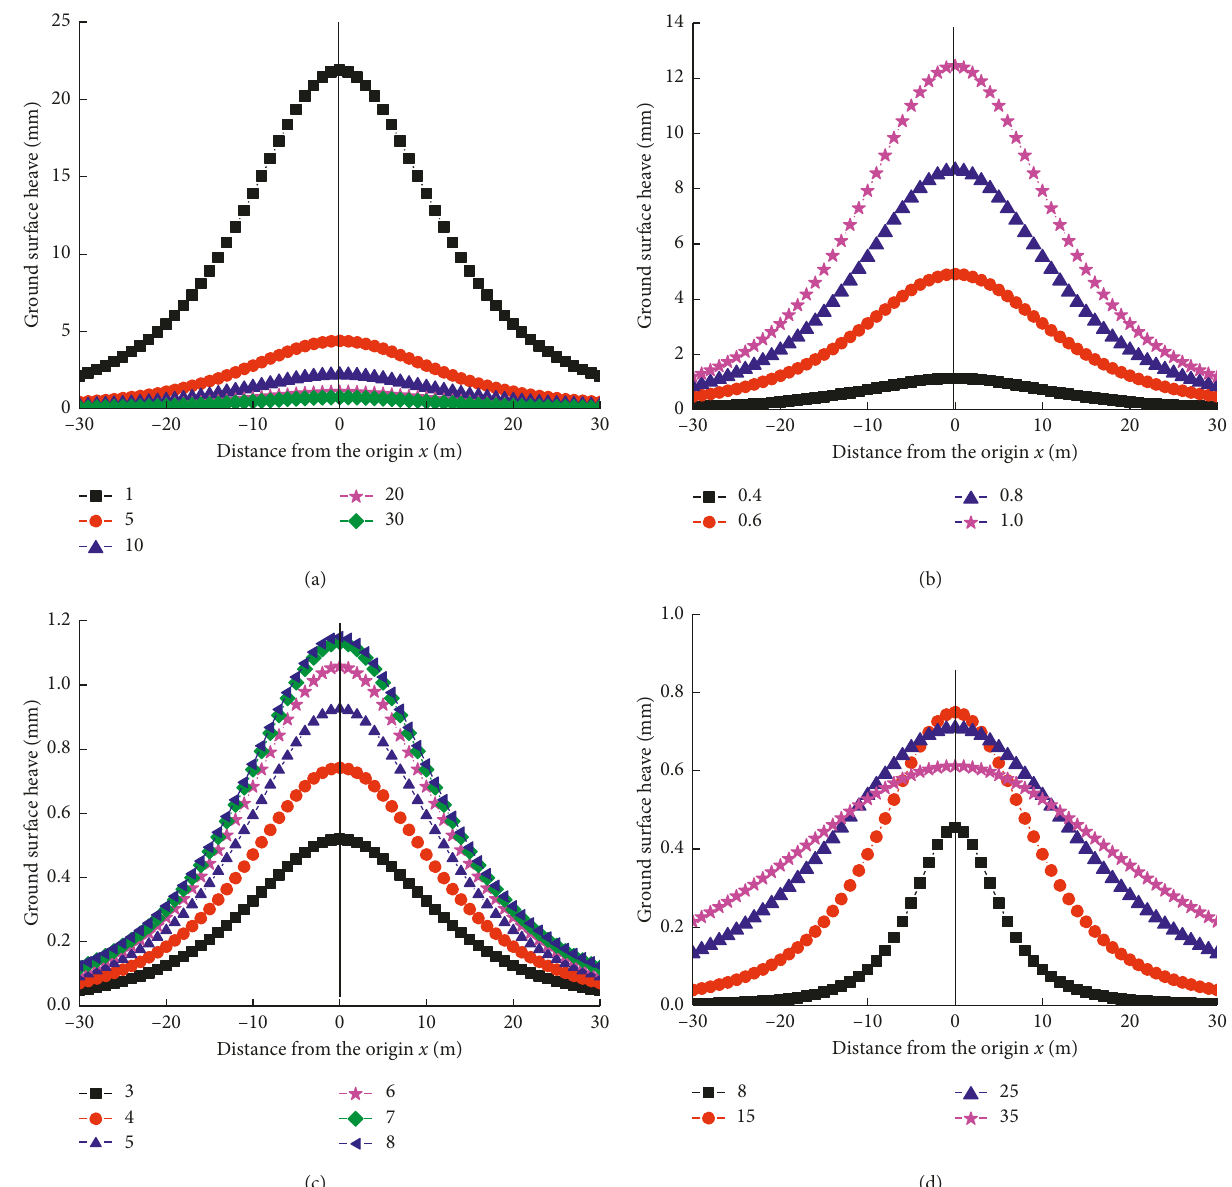
Figure 6: Relationship between the ground surface heave and (a) elastic modulus (MPa); (b) tail void grouting pressure (MPa); (c) tunnel radius (m); (d) tunnel depth